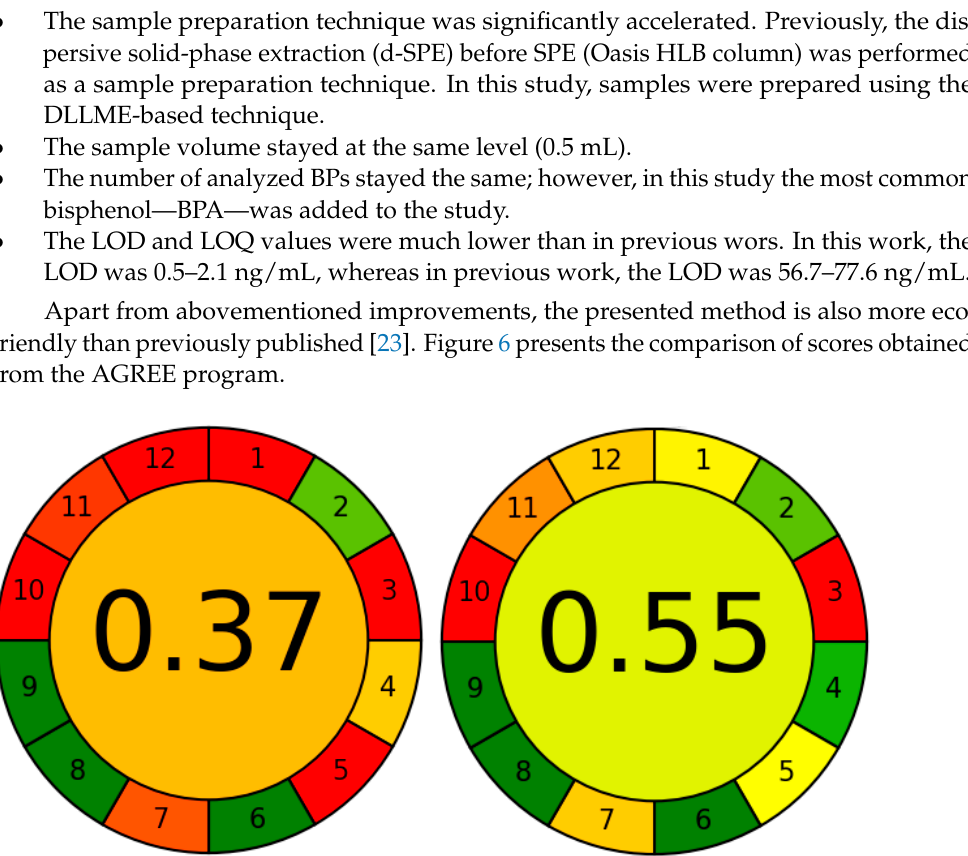
Figure 6. The comparison of two graphs comparing the greenness of two methods: ( left ) ([33]0 and ( right ) (this work) obtained from AGREE software. The meaning of each 12 points is presented in Section 4.8.